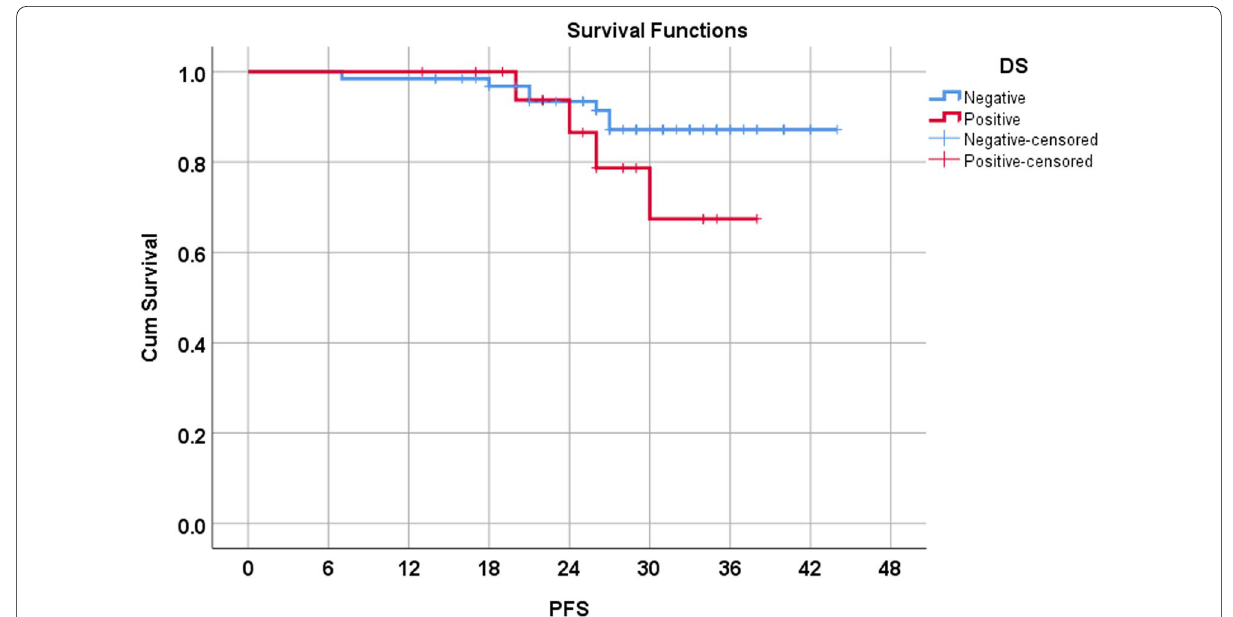
Fig. 2 Progression‑free survival curves for DS interim negative and positive groups